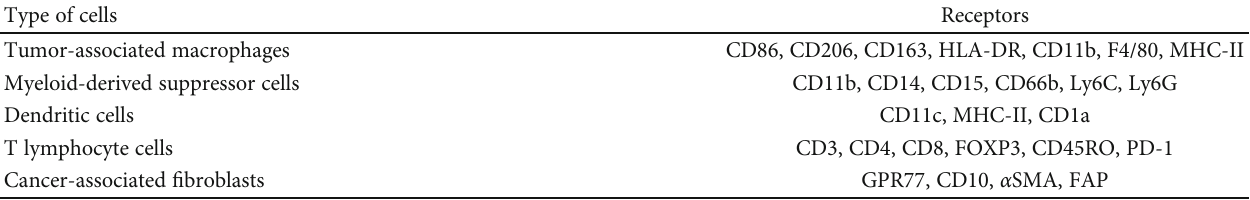
Table 2: Main overexpressing receptors that could be targeted in TIME.